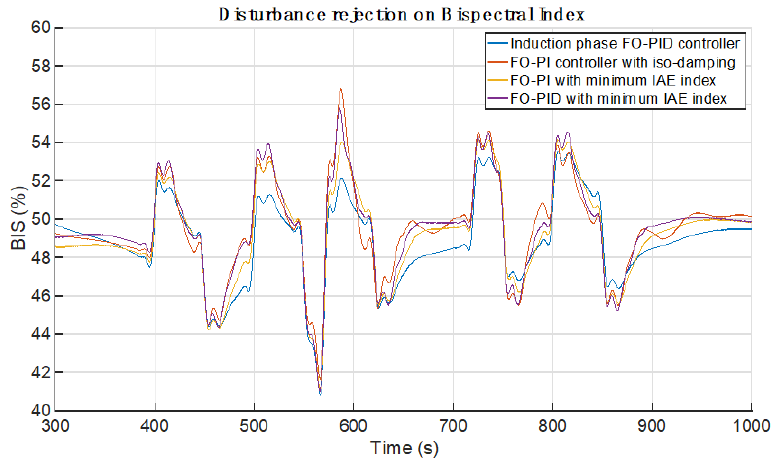
Figure 7. Comparison of different designed controllers having the same constraints—simulation results for the nominal patient 1.